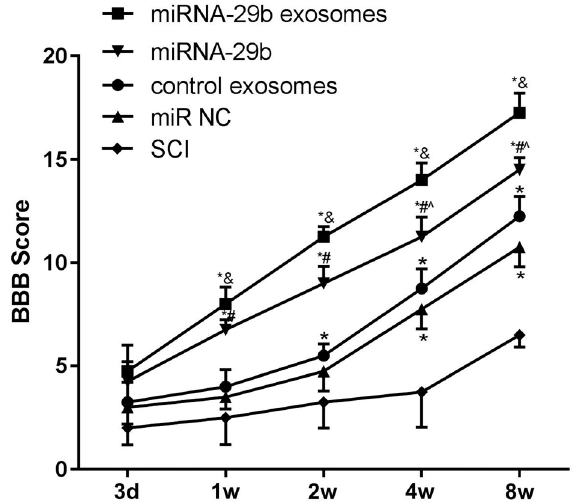
Figure 3. Basso Beattie Bresnahan (BBB) scores of rats at 3 days, 1, 2, 4, and 8 weeks post-injection. Data are reported as means ± SD. *P o 0.05 vs SCI group; & P o 0.05 vs control exosomes; # P o 0.05 vs miR NC; ̂ P o 0.05 vs miRNA-29b exosomes